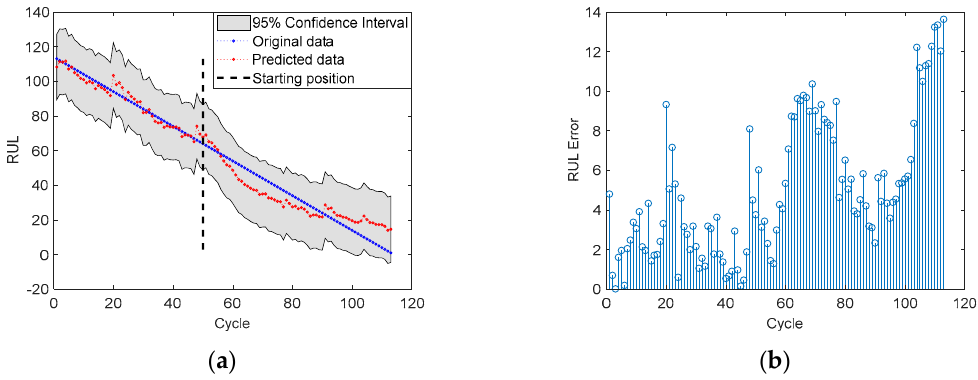
Figure 11. RUL prediction results for battery No. 5 with SP = 51: ( a ) RUL; ( b ) RUL prediction Error.